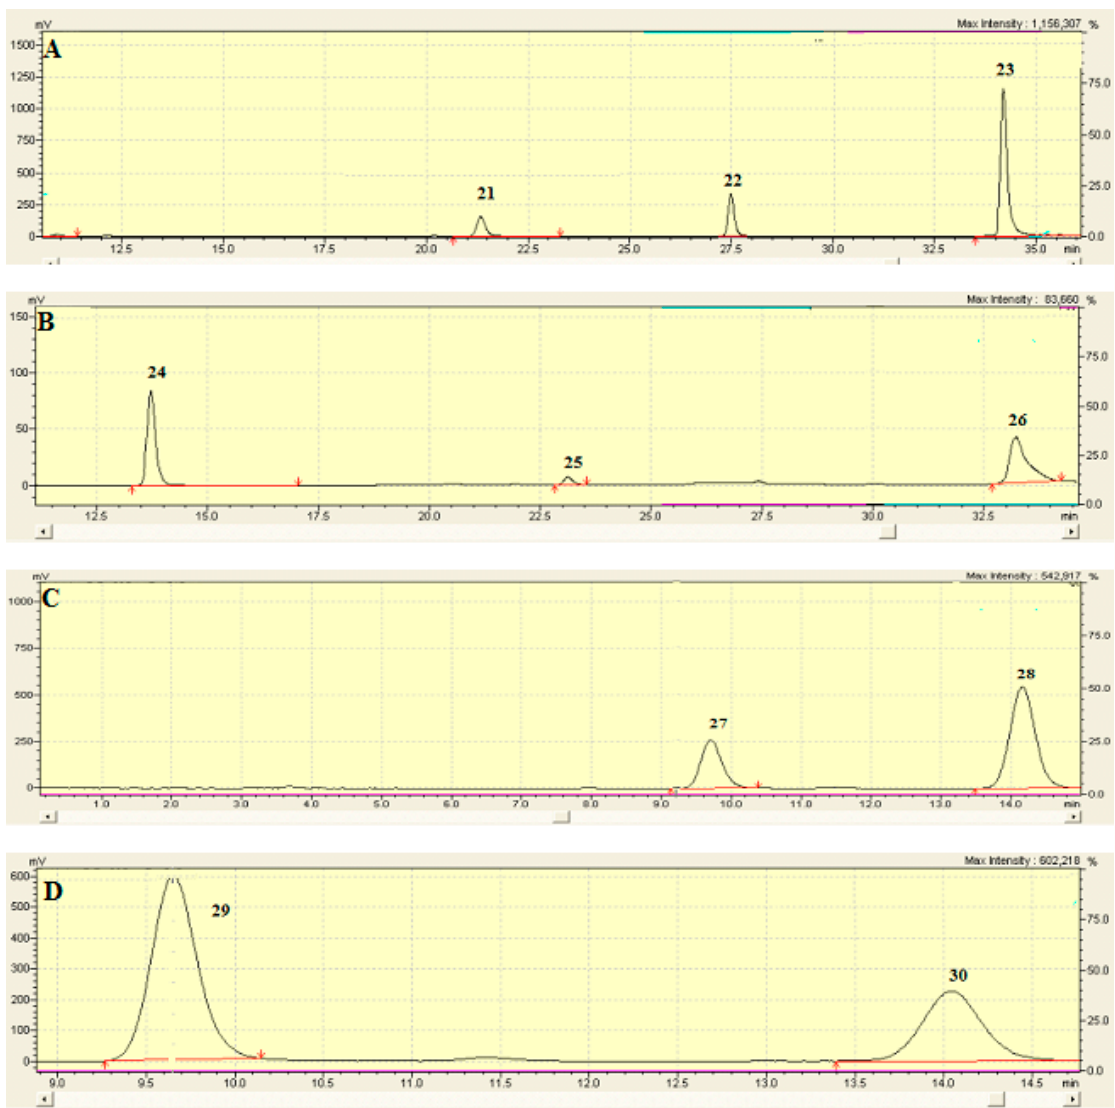
Figure A4. HPLC profiles of compounds isolated from J. communis : ( A – D ) fractions NfC, NfD, WW1 and WM1, respectively.